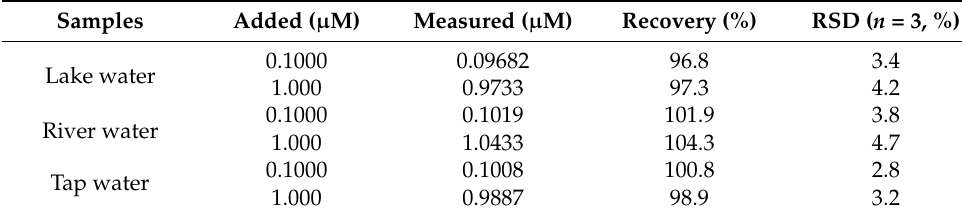
Table 2. Comparison of the performance of the MIP@QD-based sensor with previously reported analytical techniques for the determination of